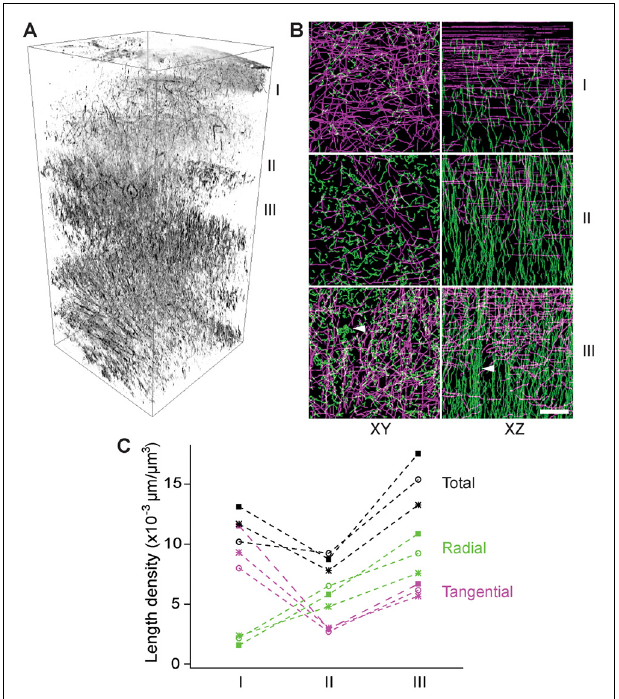
FIGURE 4 | The depth-dependent distribution of tangential and radial fibers. (A) Volumetric rendering of THG stacks in the range of 0–800 µ m of the cortex. I, II, and III: 0–100 µ m, 200–300 µ m, and 300–400 µ m below the dura, respectively (inverted contrasts). (B) The transverse (XY) and axial (XZ) projections of traced THG-positive axons exhibiting a lattice structure and fiber bundles (arrowheads) in deeper layers. Scale bar, 20 µ m. (C) The length density of traced THG-positive fibers ( N = 3).